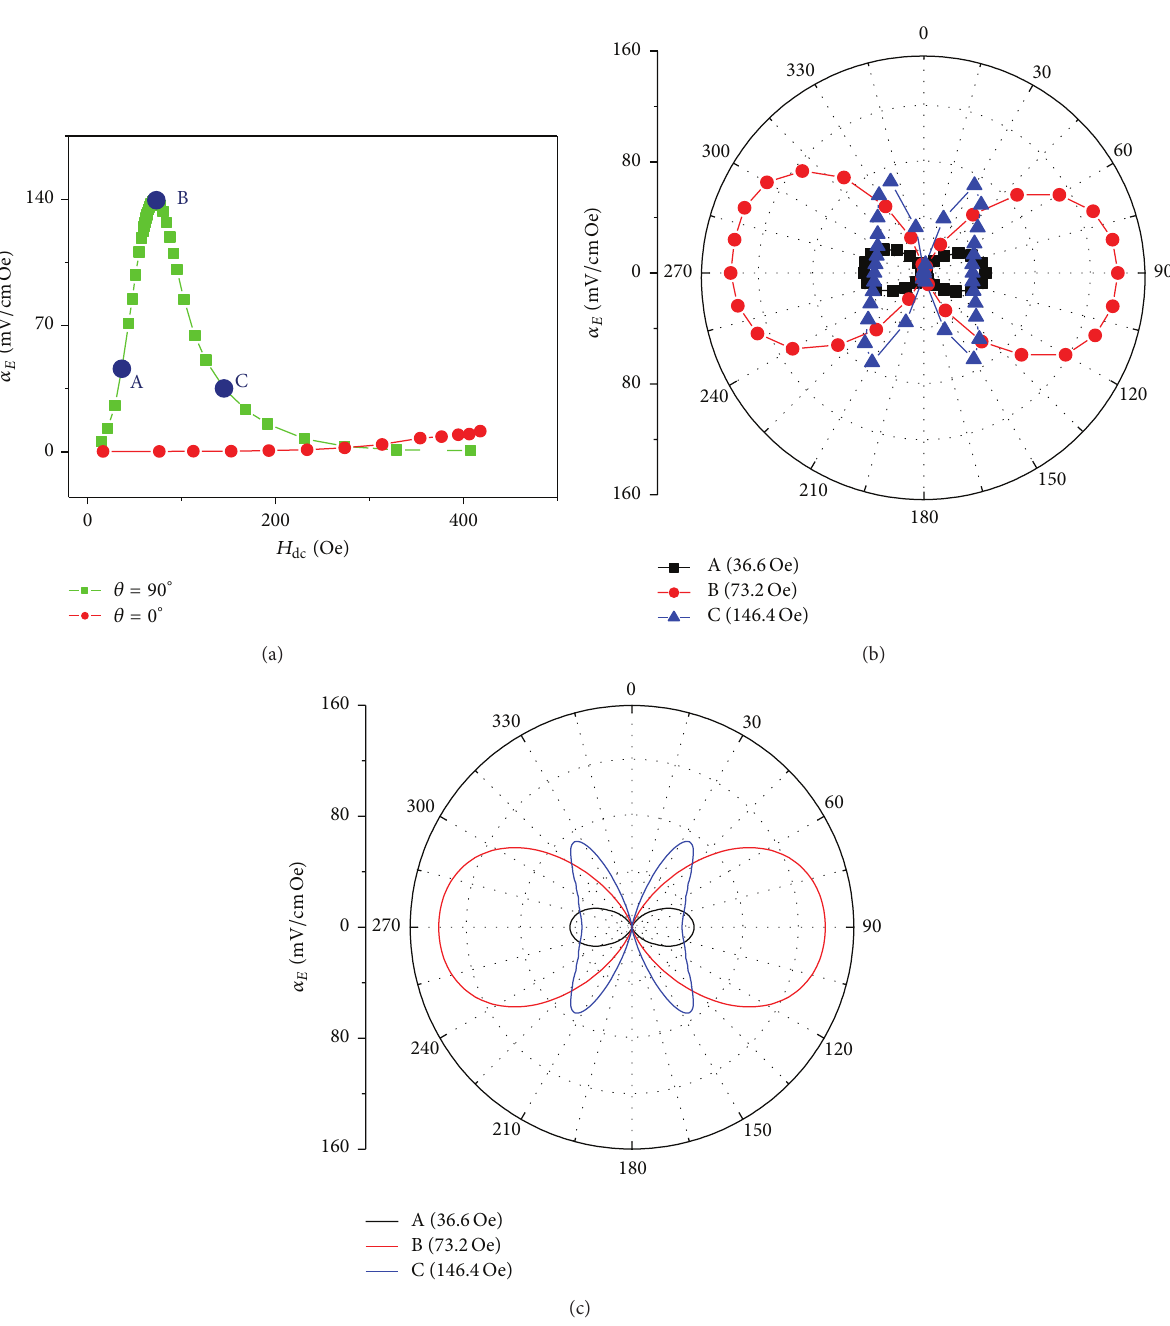
for the PZT slab (Sample 1). (b) Experimentally measured polar plots of the angular dependent ME coefficient 𝛼 𝐸 in Sample 1 and (c) the computer